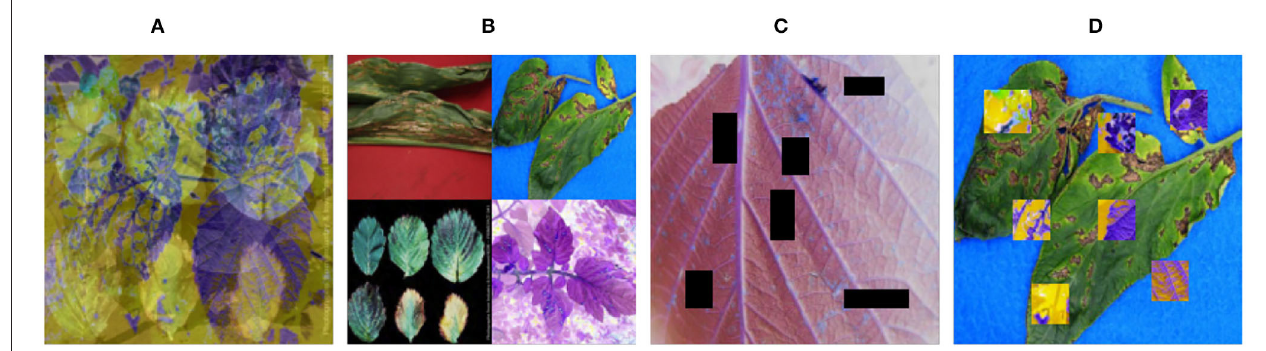
FIGURE 3 | Demonstration of five date augmentation methods. (A) Mixup; (B) Mosaic; (C) CutMix; (D)